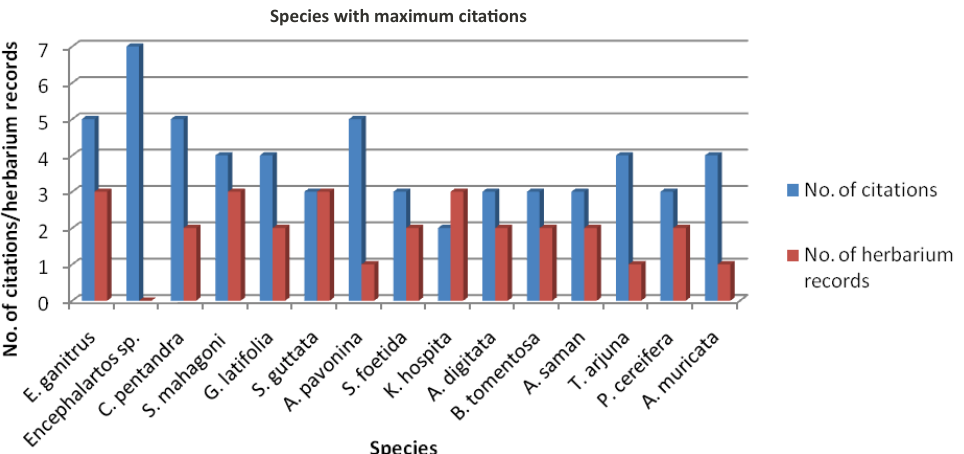
Figure 5. Species with total citations+herbarium records exceeding five have been depicted for the sake of reresentation here. The No. of herbarium records indicate the number of herbaria in which sheets of the respective species are present or occur out of the consulted